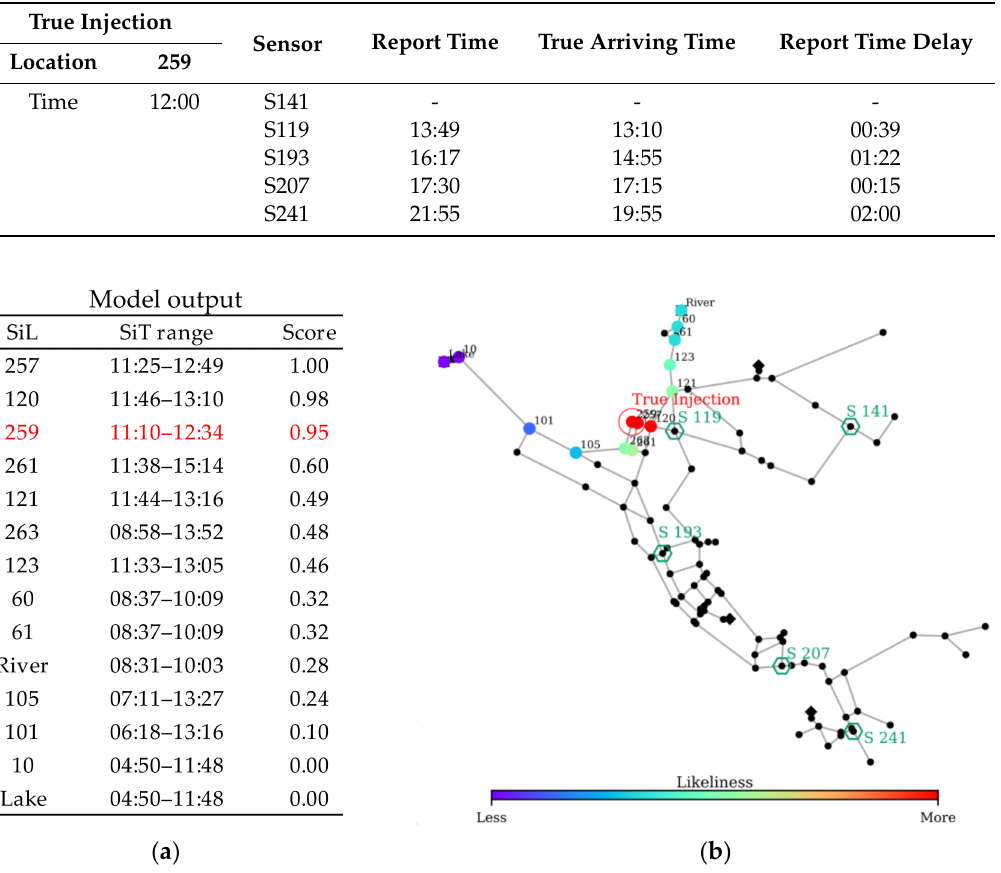
Table 8. True injection and sensor information (scenario 2).